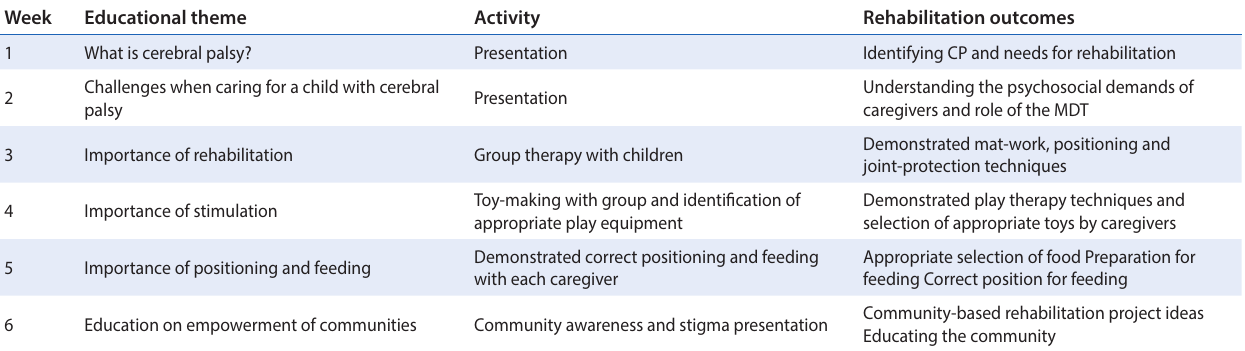
Table 1: Six-week intervention